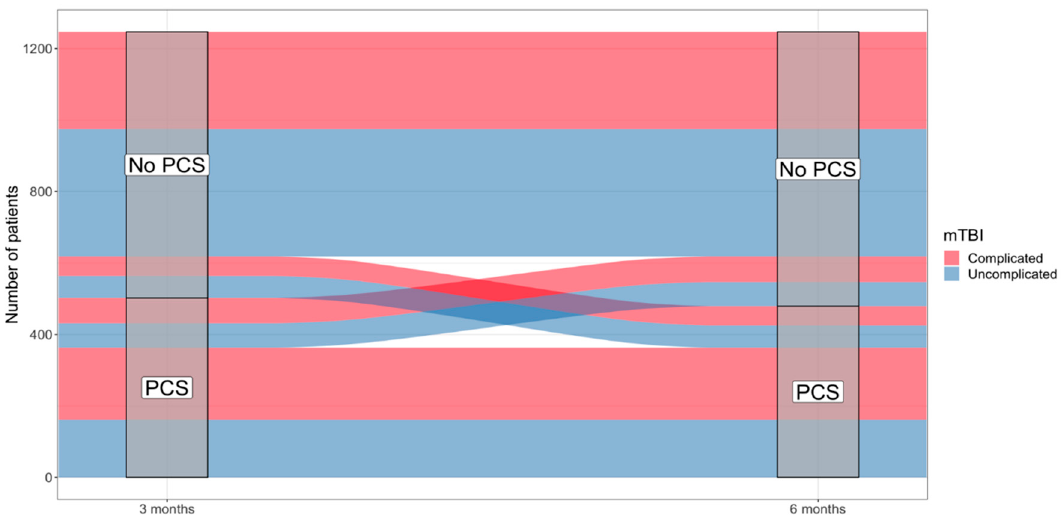
Figure 5. Trajectories of patients after uncomplicated and complicated mTBI with PCS at 3 and 6 months follow-up. PCS, post-concussion syndrome; mTBI, mild traumatic brain injury; n = number of patients.